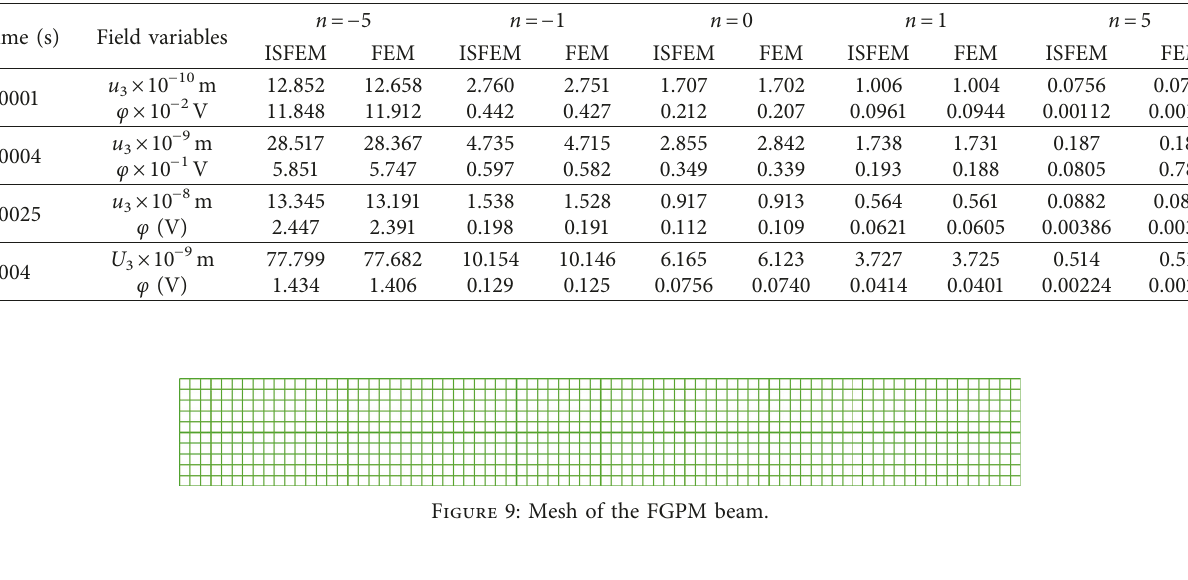
� − 5, − 1, 0, 1, and 5 of the FGPM beam